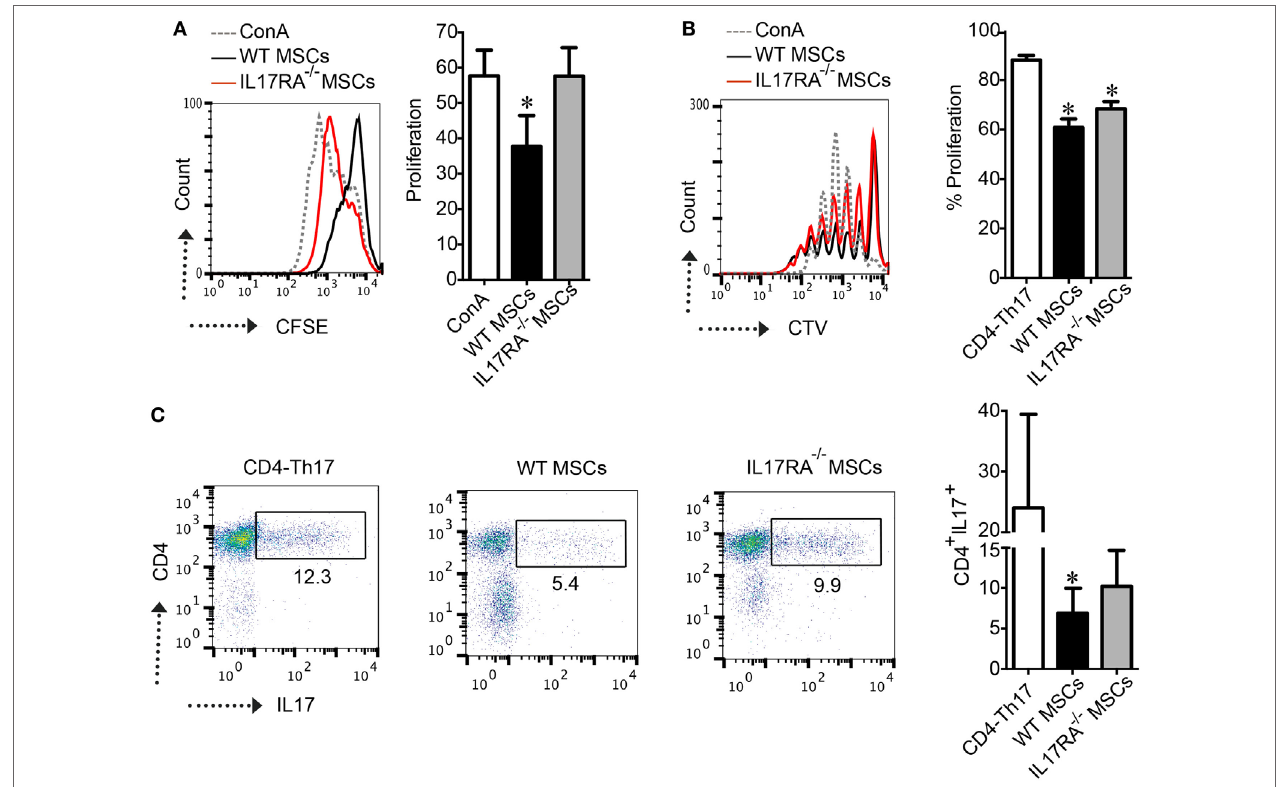
FigUre 2 | IL17RA deficiency in mesenchymal stem cells (MSCs) impaired their immunosuppressive function . (a) CFSE-labeled splenocytes were stimulated with Concanavalin A (ConA) and the proliferation of cells was measured by CFSE dilution by FACS. Results are expressed as the percentage of ConA-induced proliferation. (B,c) The effect of wild-type (WT) and IL17RA − / − MSCs on Th17 proliferation (B) and differentiation (c) was assessed using naïve T-CD4 cells labeled with CTV induced to differentiate into Th17 cells in the absence (CD4-Th17) or presence of WT or IL17RA − / − MSCs at a MSCs:T ratio of 1:10. For T cell proliferation, the percentage of proliferation was measured by CTV dilution by FACS. For Th17 characterization, intracellular detection of IL17 (Th17) was performed by FACS. Bars in the plots represent the mean ± SD of n = 4 independent experiments using four different mice each time. Statistical differences were calculated using the Kruskal–Wallis test. P- values refer to the condition without MSCs (CD4-Th17). * P < 0.05, ** P <